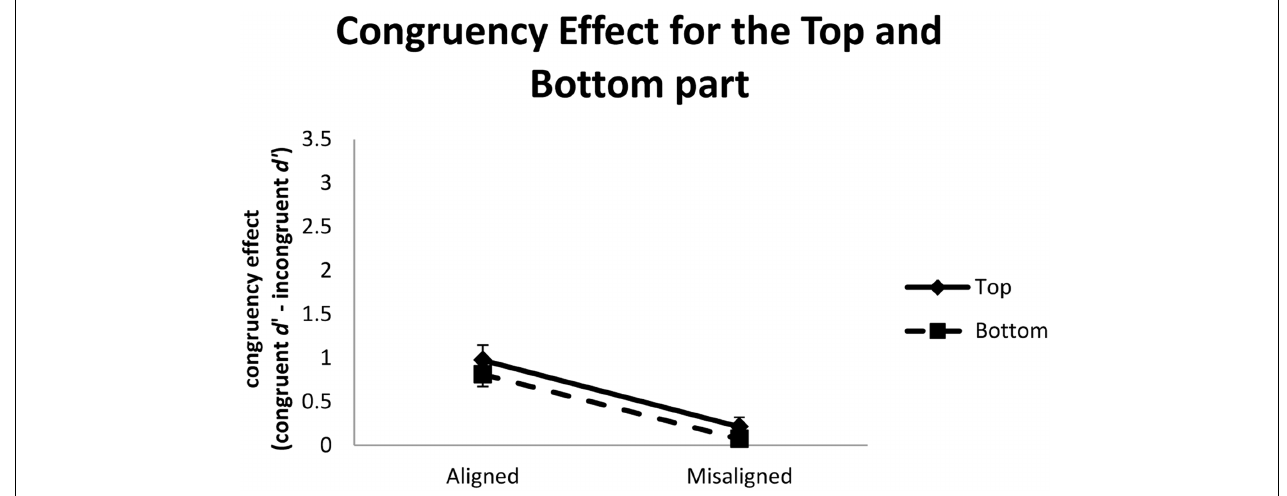
FIGURE 8 | Congruency effects, defined as the difference in d ’ between congruent and incongruent trials, as a function of face part (top vs. bottom) and alignment (aligned vs. misaligned) in Experiment 2. Error bars indicate ± 1 standard error of